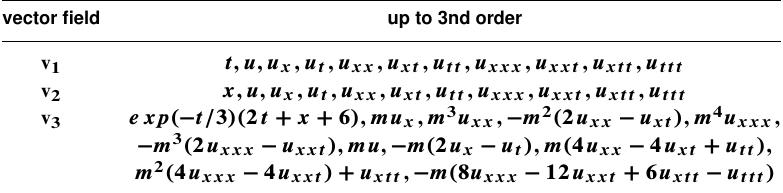
Table 10. Differential invariants for MBBM equation vector